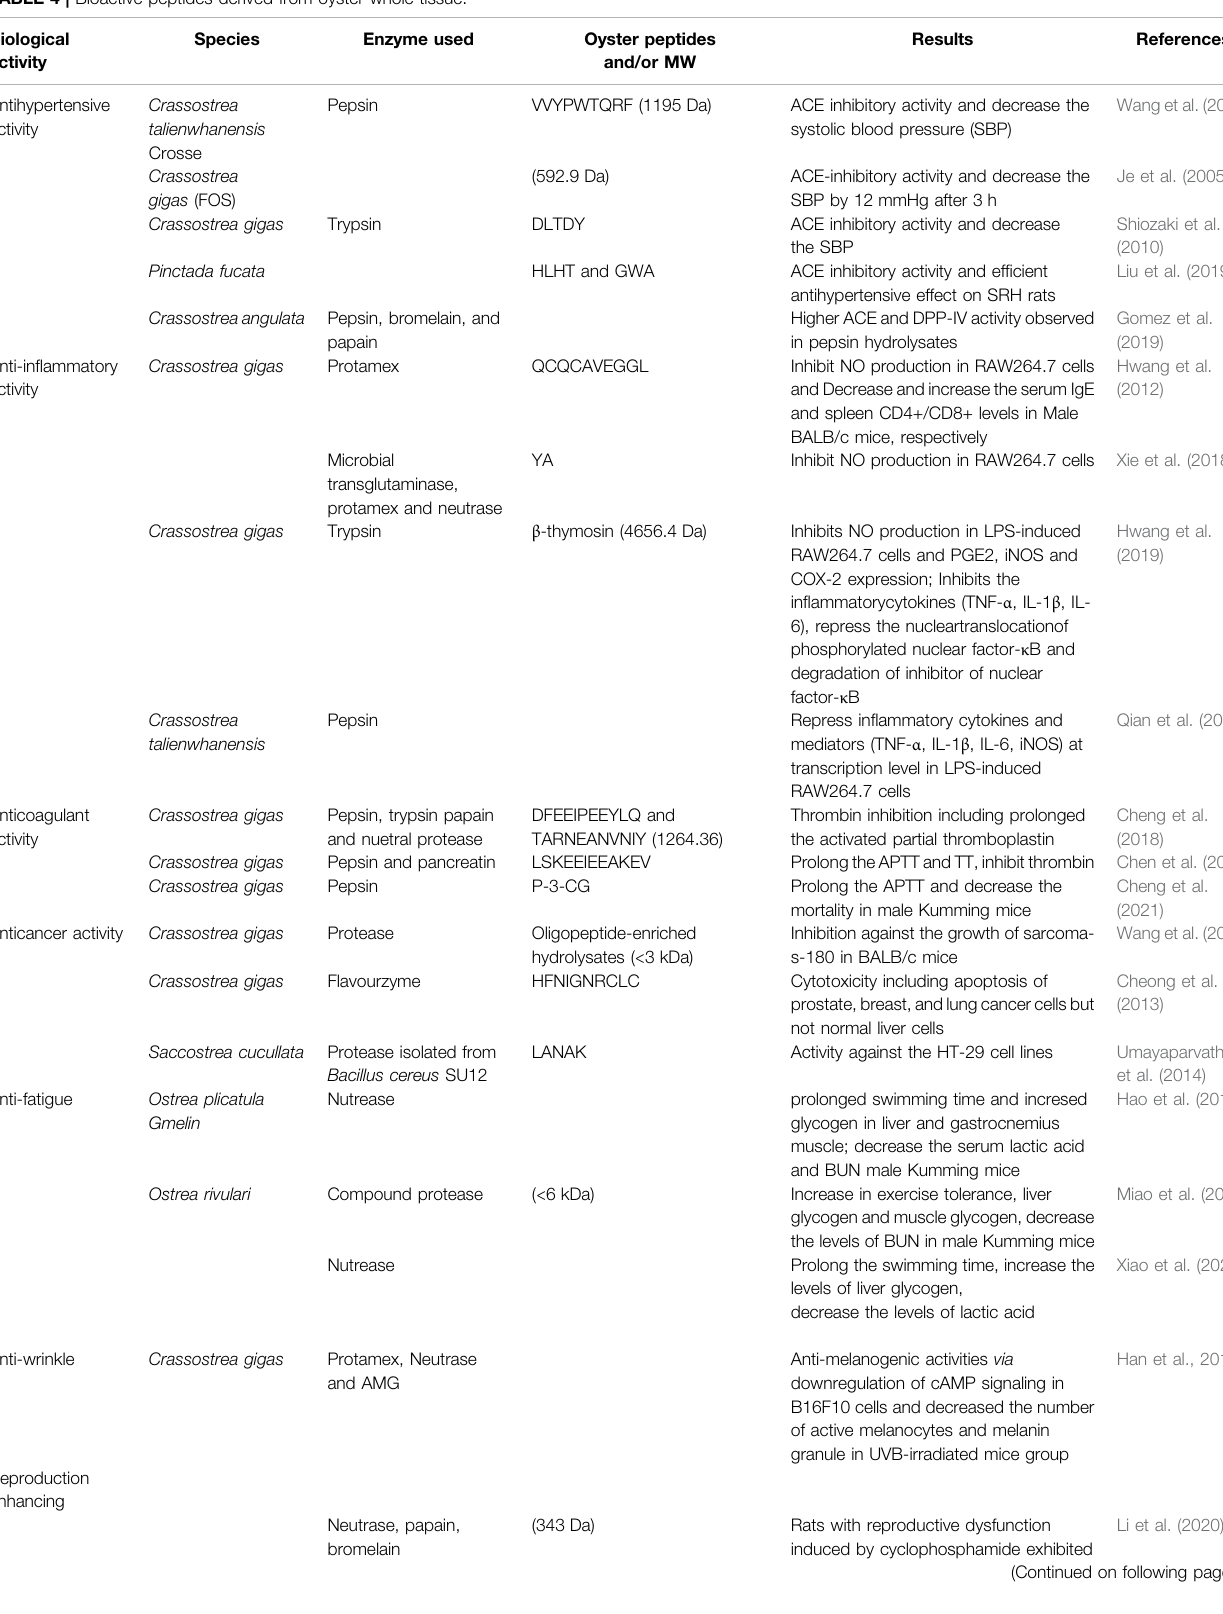
TABLE 4 | Bioactive peptides derived from oyster whole